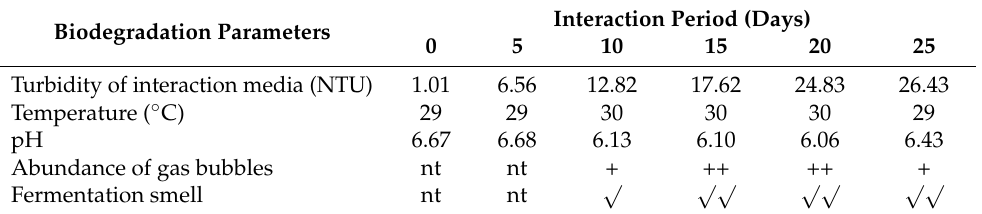
Table 4. Biodegradation parameters of bacterial consortium suspension toward the PAH contaminants. Biodegradation